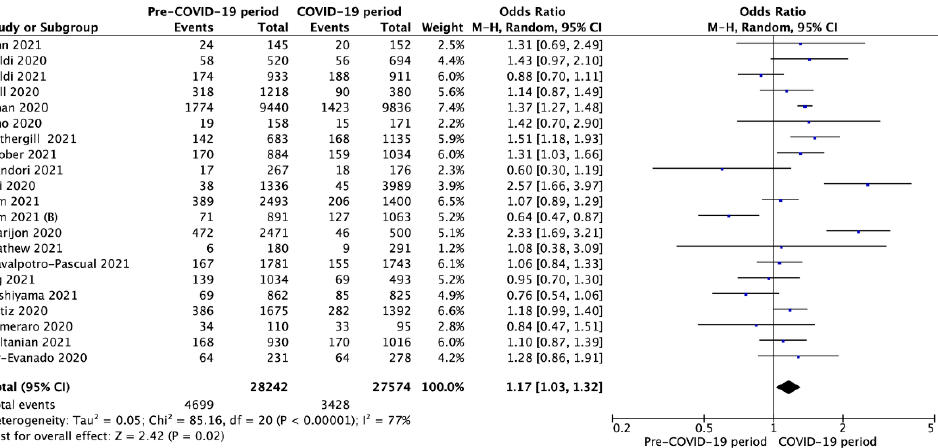
to 1.32; p < 0.001; Figure 3). 1.32; p < 0.001; Figure 3).